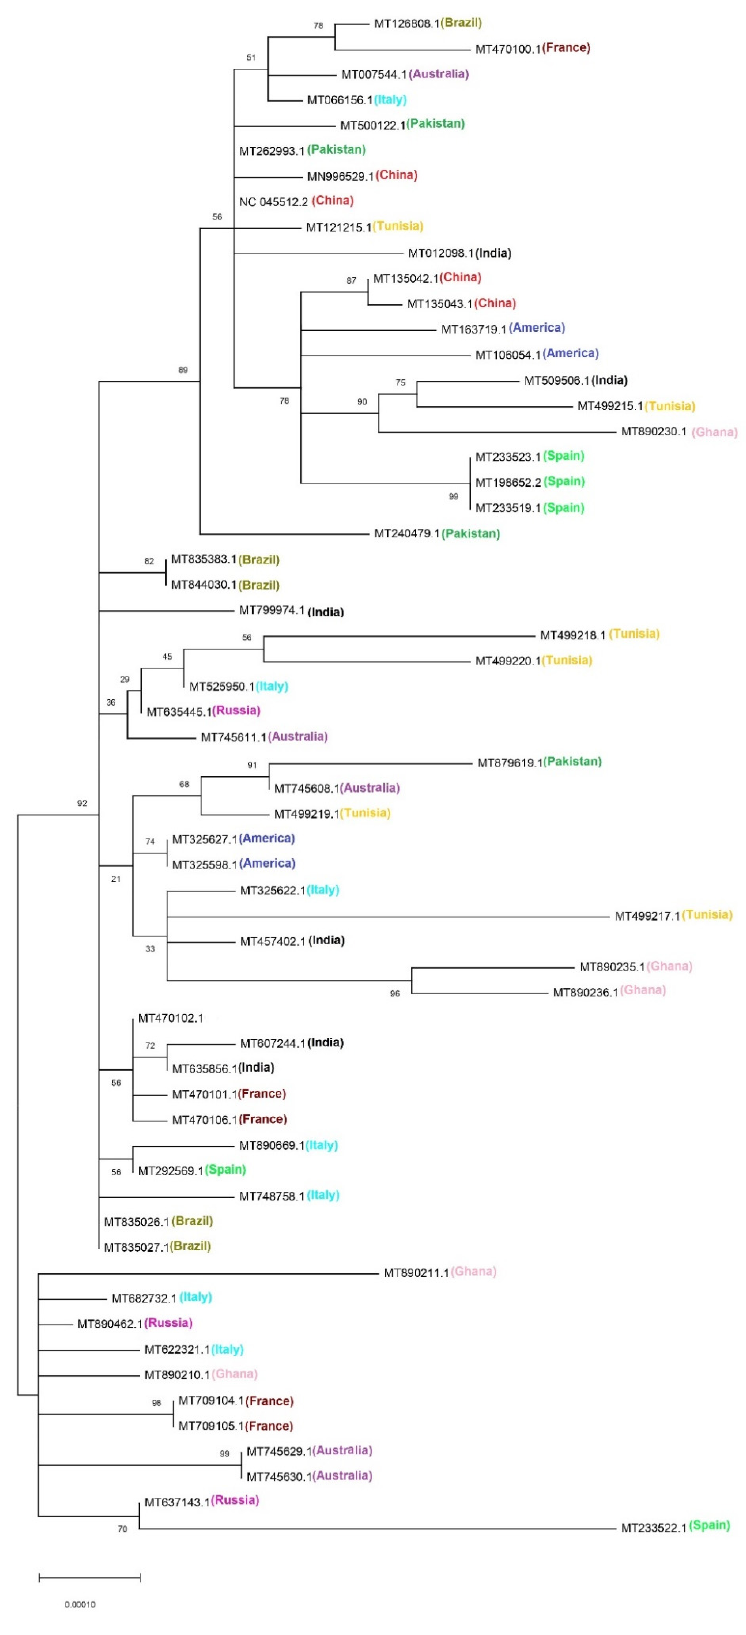
Figure 6. Phylogenetic tree based on the whole genome sequences of 60 SARS-Cov-2 strains. The tree was generated by the maximum likelihood (ML) method using the MUSCLE online tool.